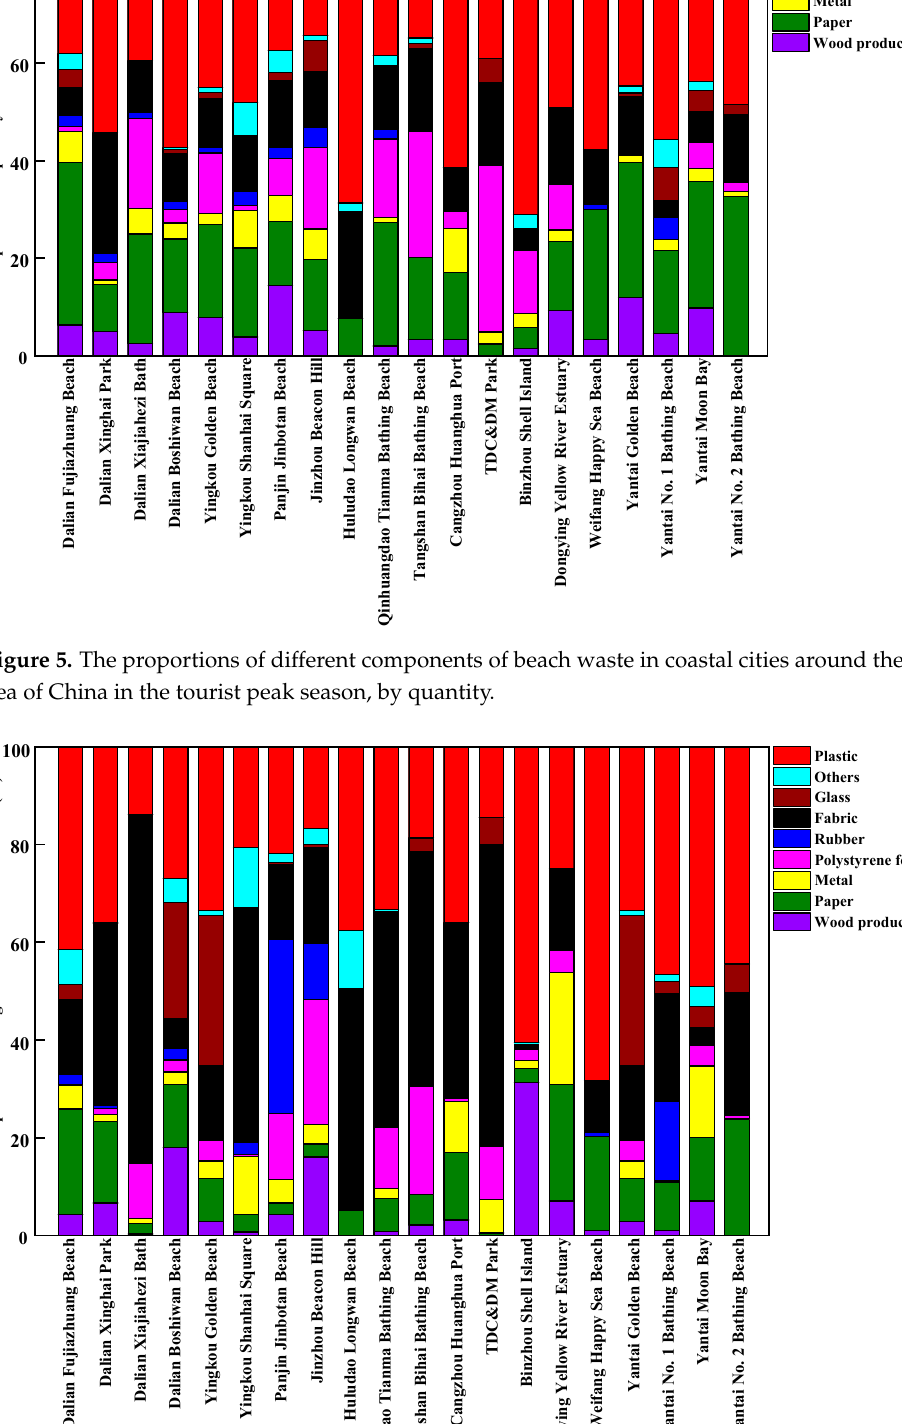
Figure 6. The proportions of different components of beach waste in coastal cities around the Bohai Sea of China in the tourist peak season, by weight.